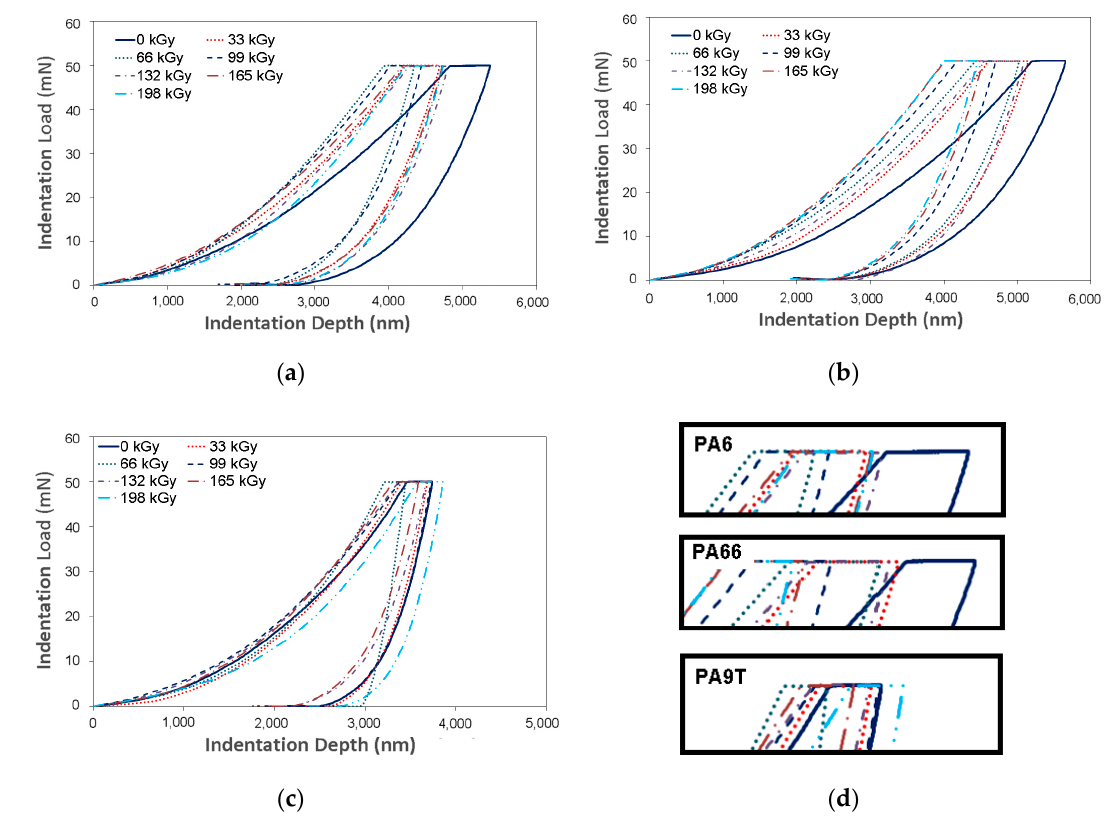
Figure 5. Indentation curve: ( a ) polyamide PA 6; ( b ) PA 66; ( c ) PA9T; ( d ) detail.